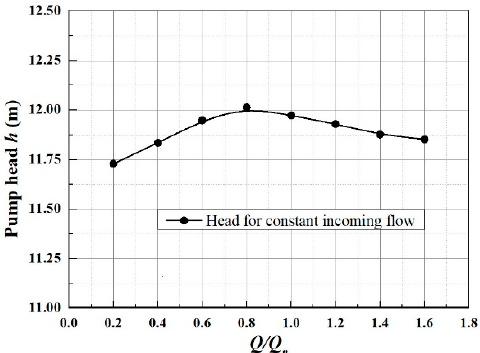
Figure 4. Head of pump under the constant inlet incoming flow rate.